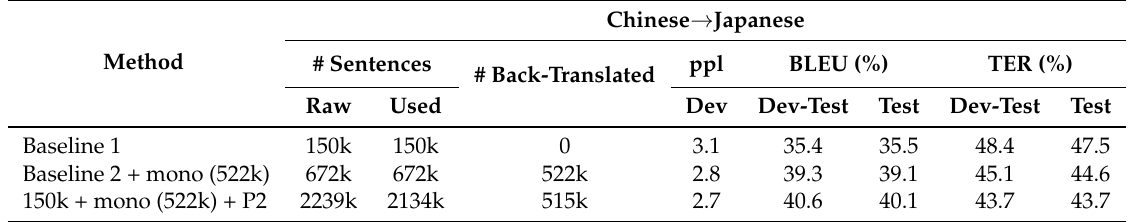
Table 7. Experiment results of Chinese → Japanese MT with 150k sentences and 522k monolingual sentences. “ppl” denotes perplexity. “Dev” denotes development data. “Dev-test” denotes development-test data.